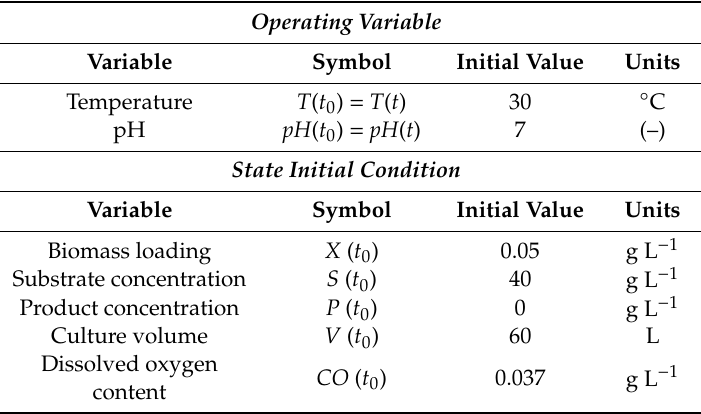
Table 4. Fixed operating and initial state conditions as per the original experimental study